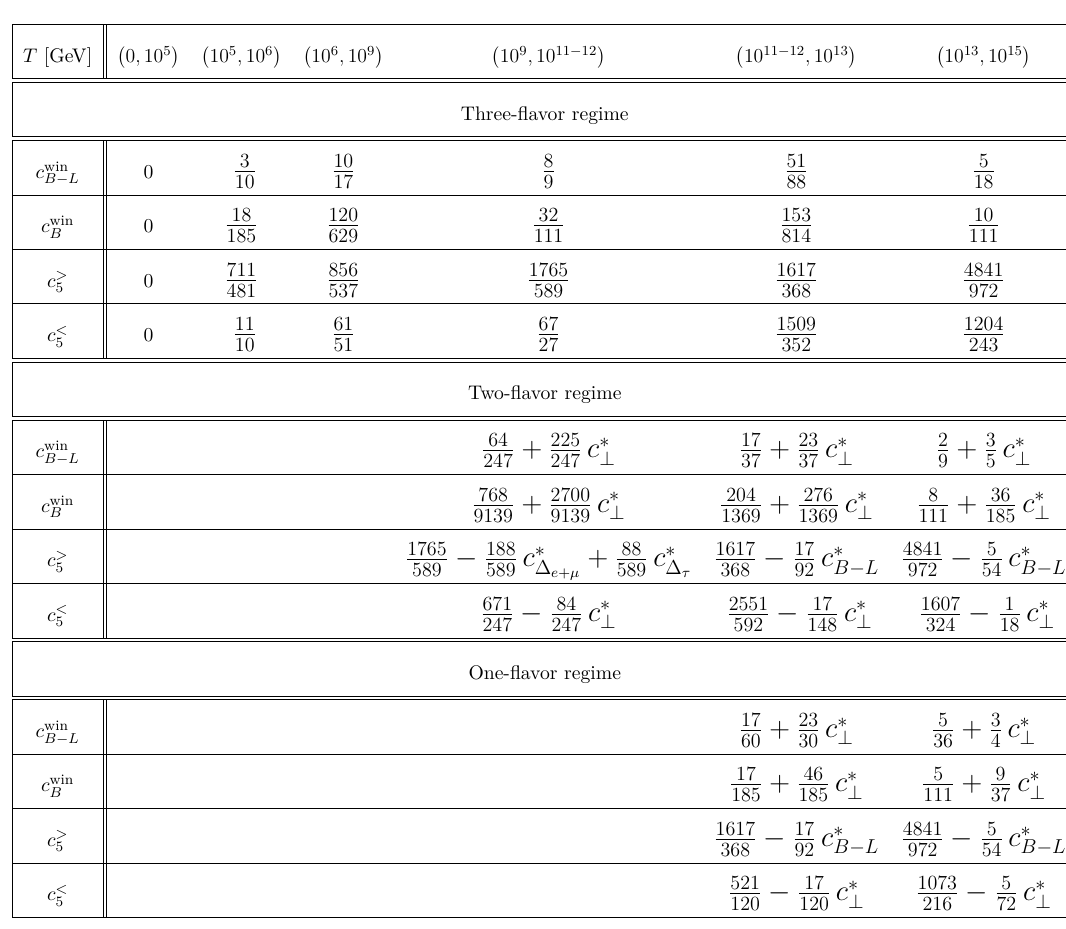
Table 2 . Numerical coefficients describing the outcome of wash-in leptogenesis. c win relate the B − L and B asymmetries generated during wash-in leptogenesis to the η χ reference asymmetry, η B − L = c win η χ and η B = c win η χ [see eqs. (4.27) and (4.28)], which is valid at the B − L B